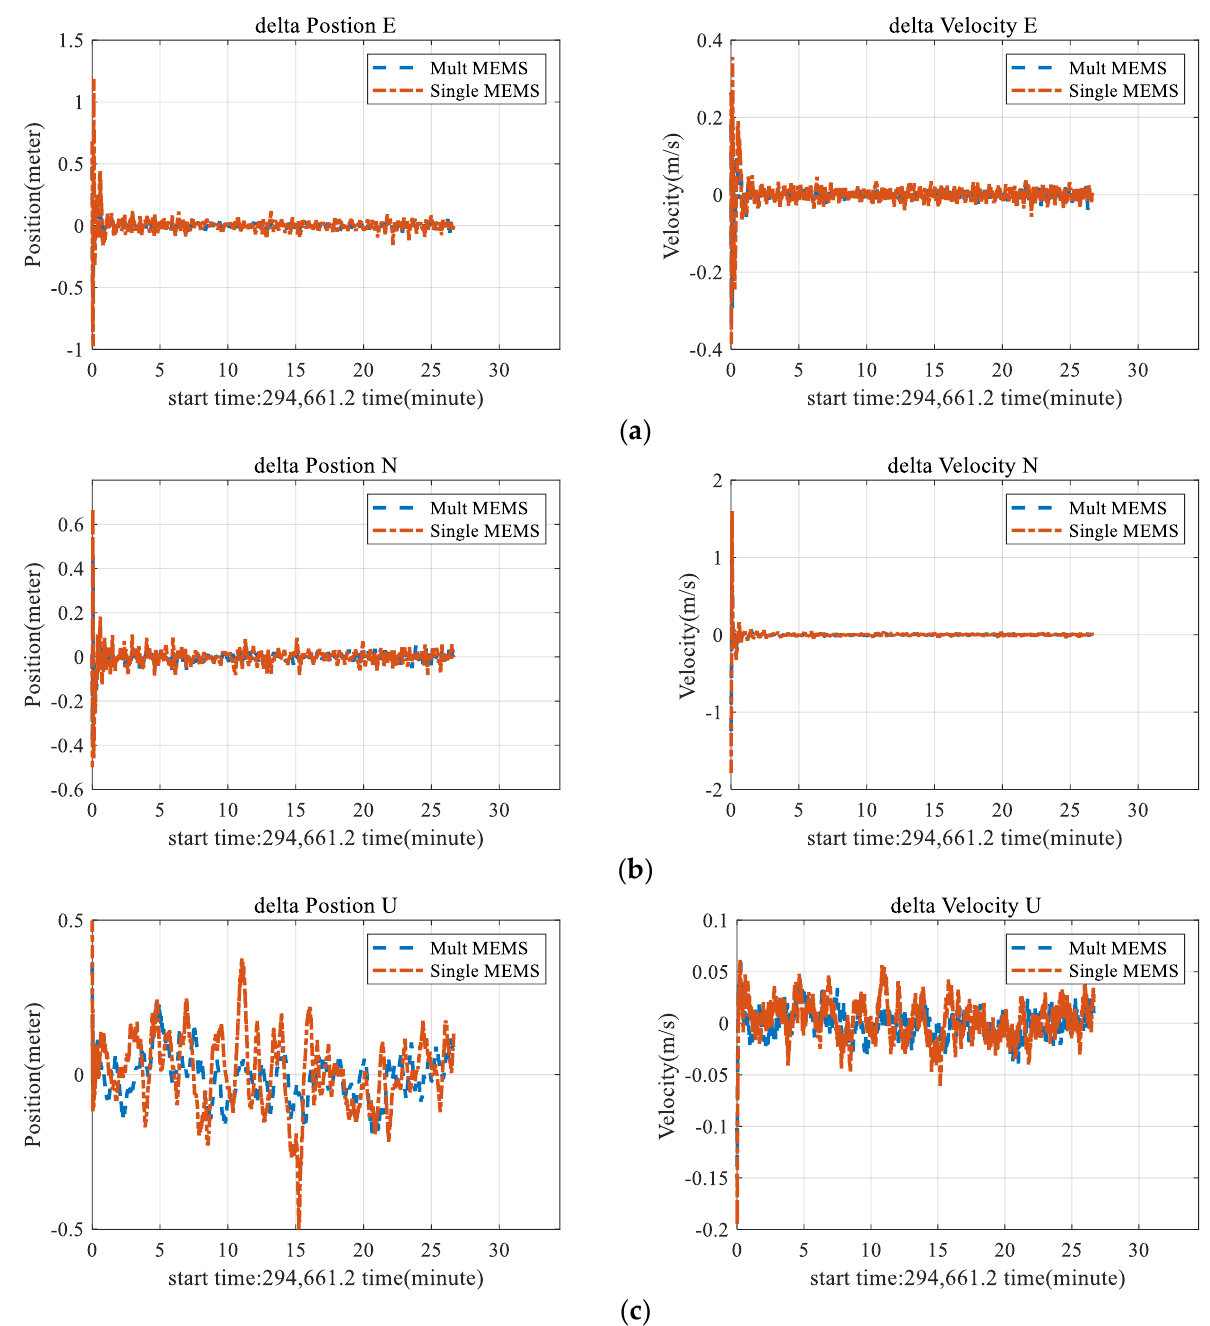
Figure 11. Deviation of position and velocity. ( a ) Position deviation and velocity deviation in the E direction. ( b ) Position deviation and velocity deviation in the N direction. ( c ) Position deviation and velocity deviation in the U direction.